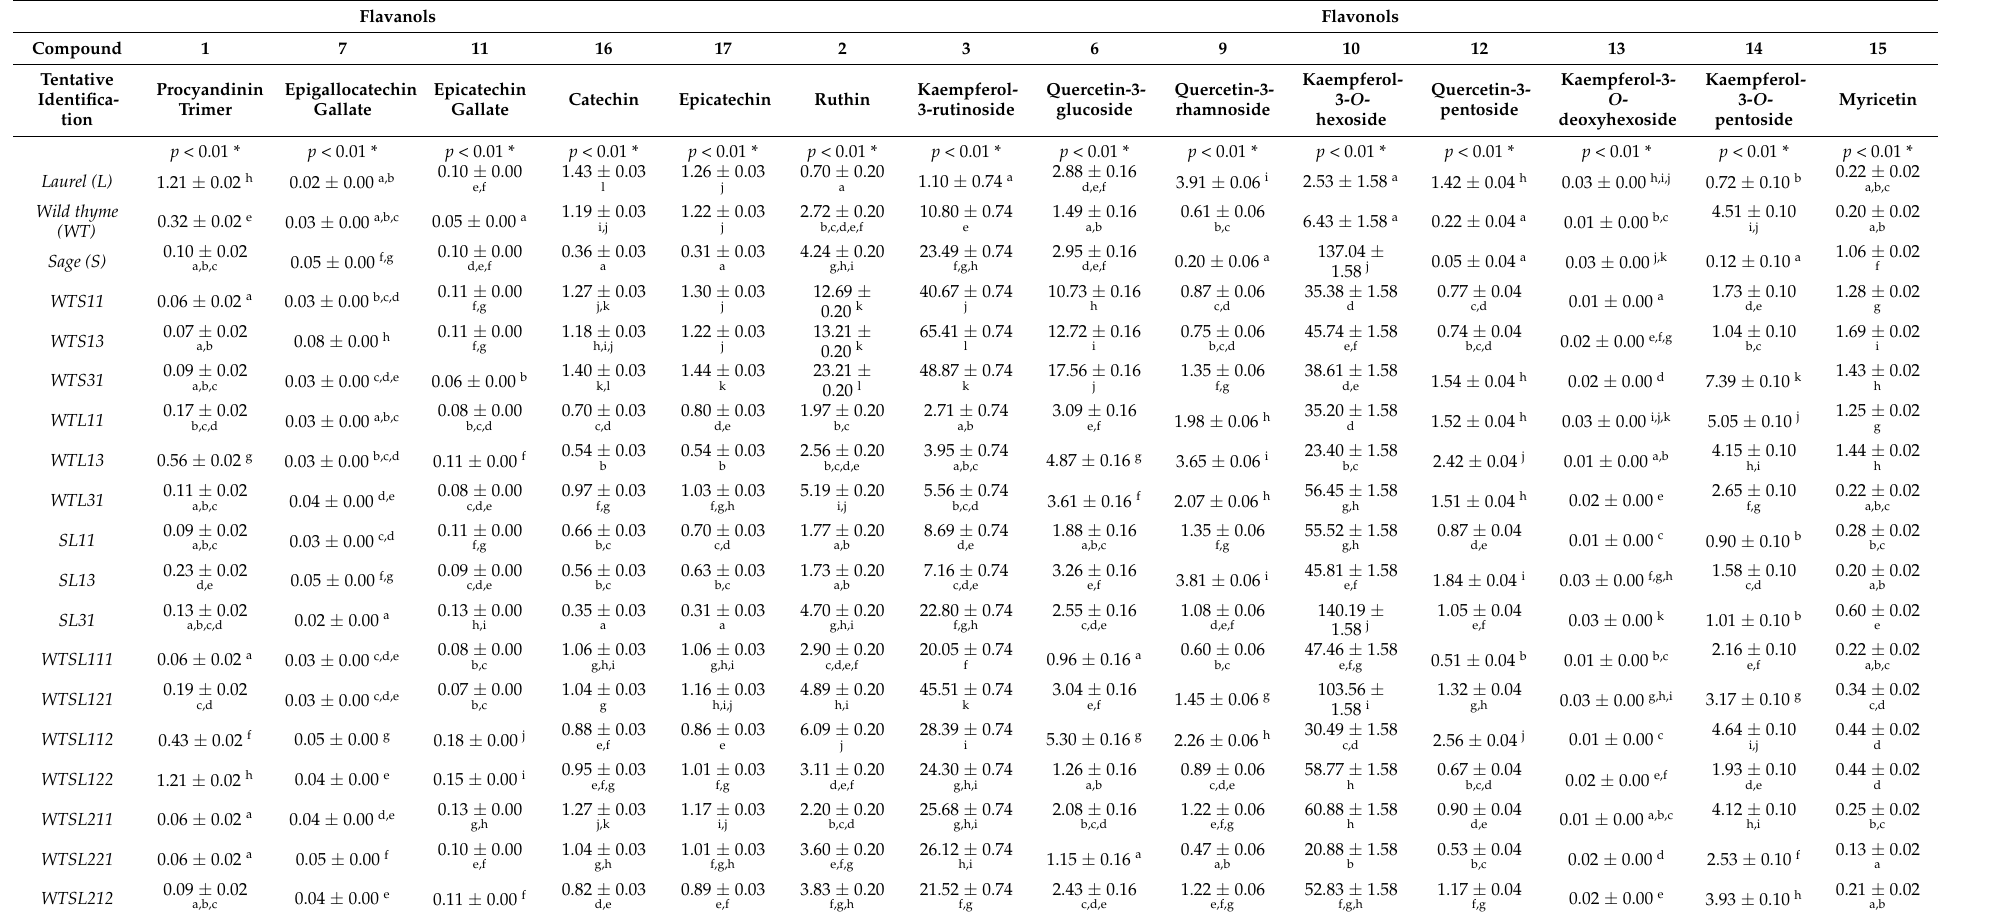
Table 3. Polyphenolic characterization (g L − 1 of the sample) of sage, wild thyme and laurel herbal extract and their mixtures (Table 1). Flavanols